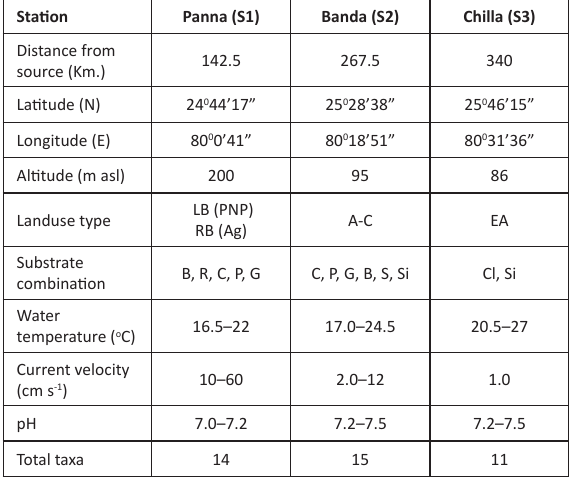
Table 1. The geographical co-ordinates, physical characteristics, land use and substrate combinations found at each sampling location in the Ken river. The substrate combination at each location begins with dominant substrate